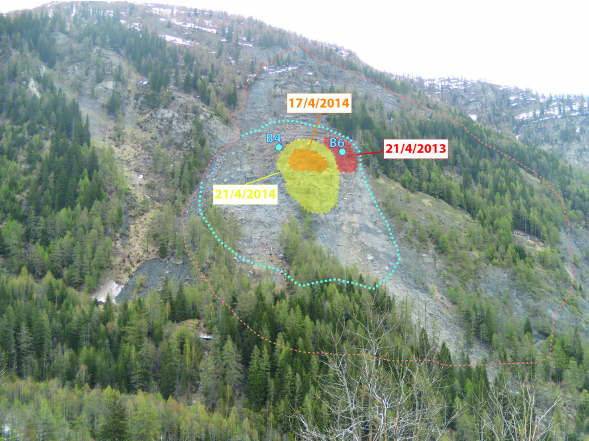
Figure 3. Frontal view of the La Saxe rockslide (April 2013). Red dashed line is the limit of the unstable slope, while blue dashed line defines the most active landslide sector. B4 and B6 are the lo- cation of the RTS targets considered for the failure forecast. Col- ored areas represent the zones collapsed on 21 April 2013 (reddish), 17 April 2014 (orange), and 21 April 2014 (yellow),